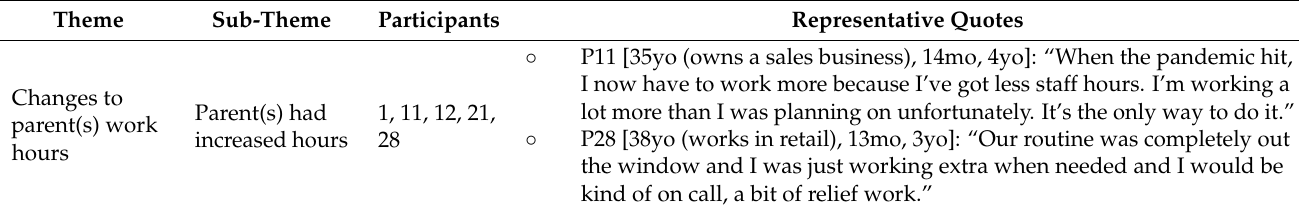
Table 1. Influence of COVID-19 on family